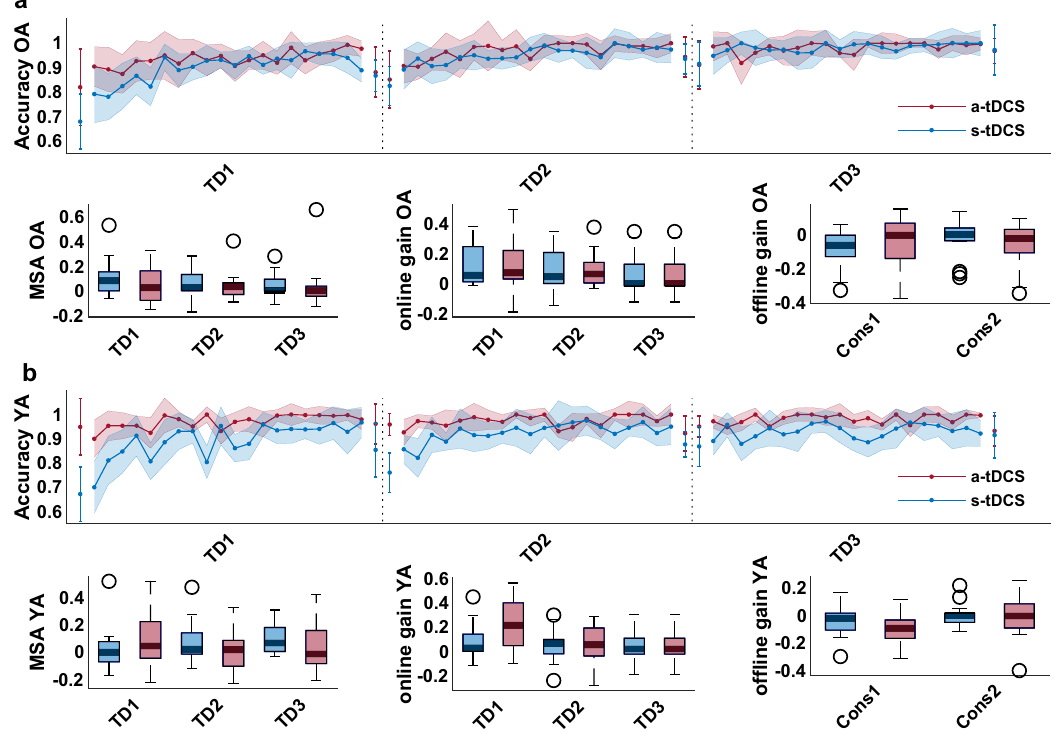
Figure 3. ( a ) OA. ( b ) YA. Line Graph shows median values ± 95% Confidence Interval. Red line represents a-tDCS group, blue line represents s-tDCS group. Separated values represent transfer trials, connected lines represent training trials. Dotted lines indicate separation of training days. Boxplots show median with 25th and 75th percentiles. Outliers are depicted as dots. Red boxes represent the a-tDCS group, blue boxes represent the s-tDCS